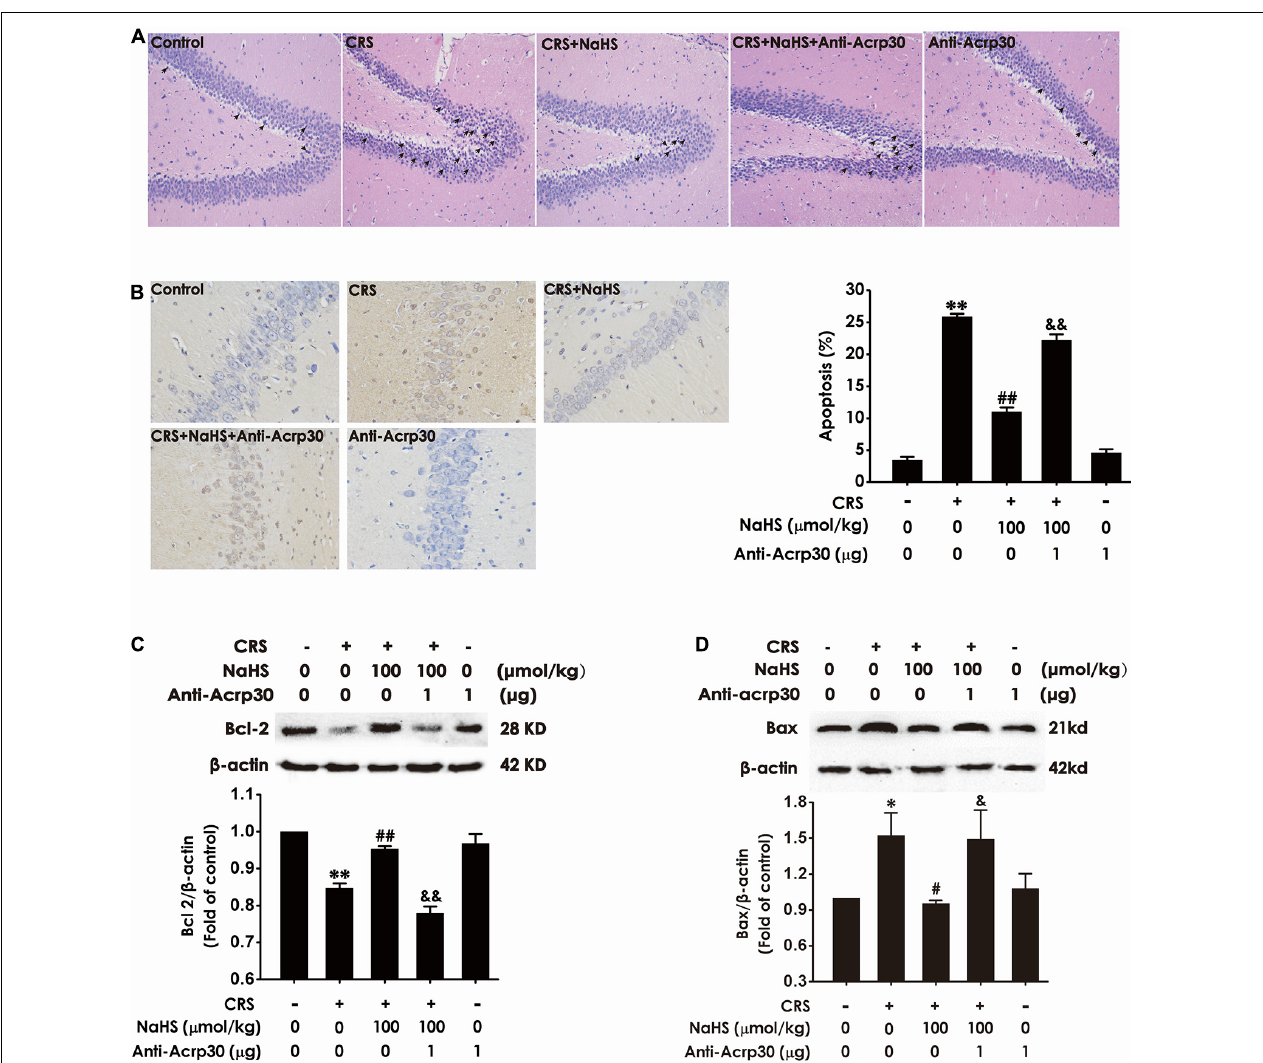
FIGURE 5 | Effects of Anti-Acrp30 on NaHS-attenuated hippocampal apoptosis in CRS-exposed rats. Rats were co-treated with NaHS (100 µ mol/kg/day, i.p.) and CRS (6 h/day) for 3 weeks, and then co-administrated with Anti-Acrp30 (1 µ g/day, i.c.v.) for further 1 week. (A) The hippocampus lesion was analyzed by HE staining (magnification × 200). (B) The hippocampal neuronal apoptosis was analyzed by TUNEL staining (magnification × 400). The expressions of Bcl-2 (C) and Bax (D) in the hippocampus were measured by western blot analysis. Date are mean ± SEM ( n = 3–4/group). * P < 0.05, ** P < 0.01, vs. control group; # P < 0.05, ## P < 0.01, vs. CRS-exposed alone group; & P < 0.05, && P < 0.01, vs. co-treatment with NaHS and CRS